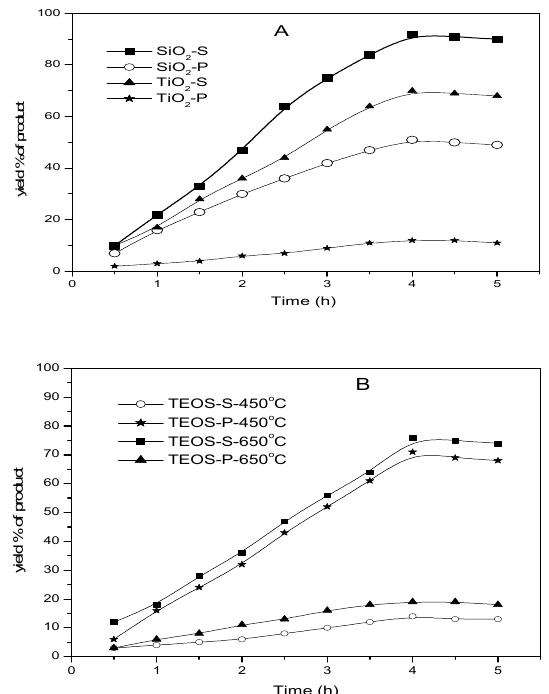
Figure 9. Plot of yield % of product versus reaction time for reaction of resorcinol and ethyl acetoacetate using different catalysts, with amount 10 wt %. Plot ( A ) sulfated and phosphate silica and titania, plot ( B ) silica prepared from TEOS treated with sulfuric and phosphoric acid calcined at 450 and 650 °C.